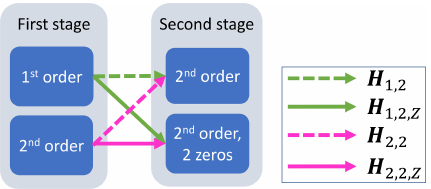
Figure 6. Frequency-domain model structures considered and two- stage model fitting